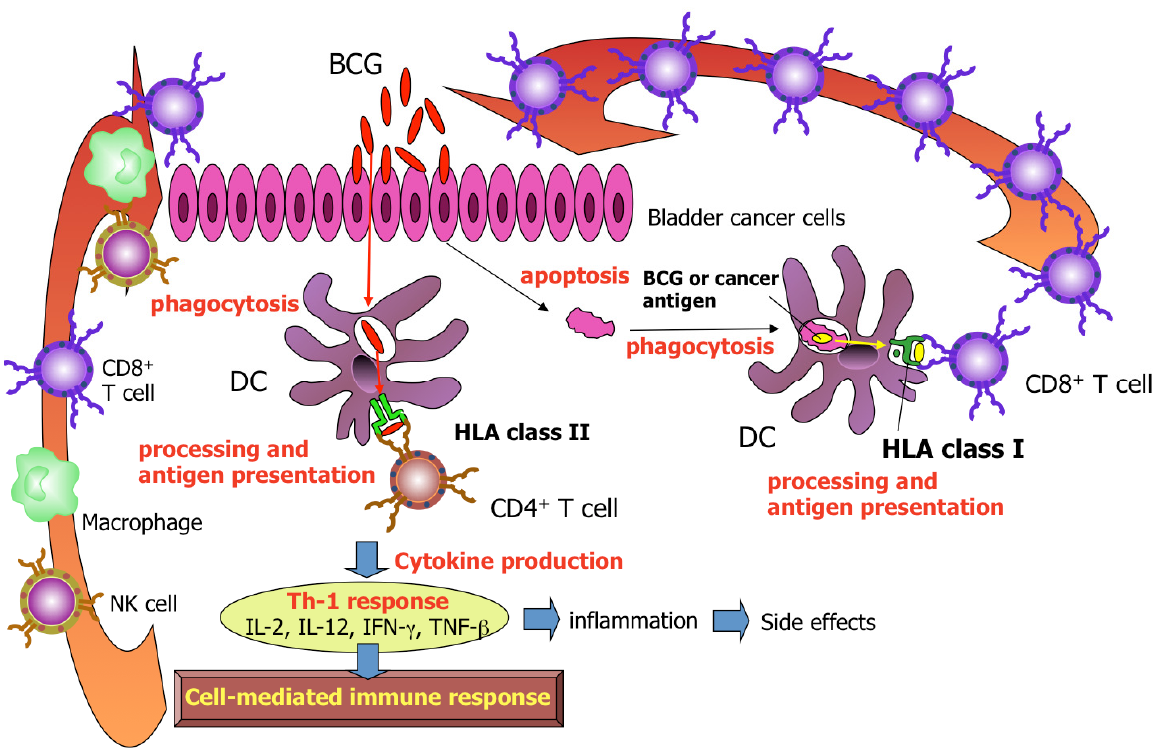
Figure 1. Suggested cascade of immune response induced by intravesical BCG